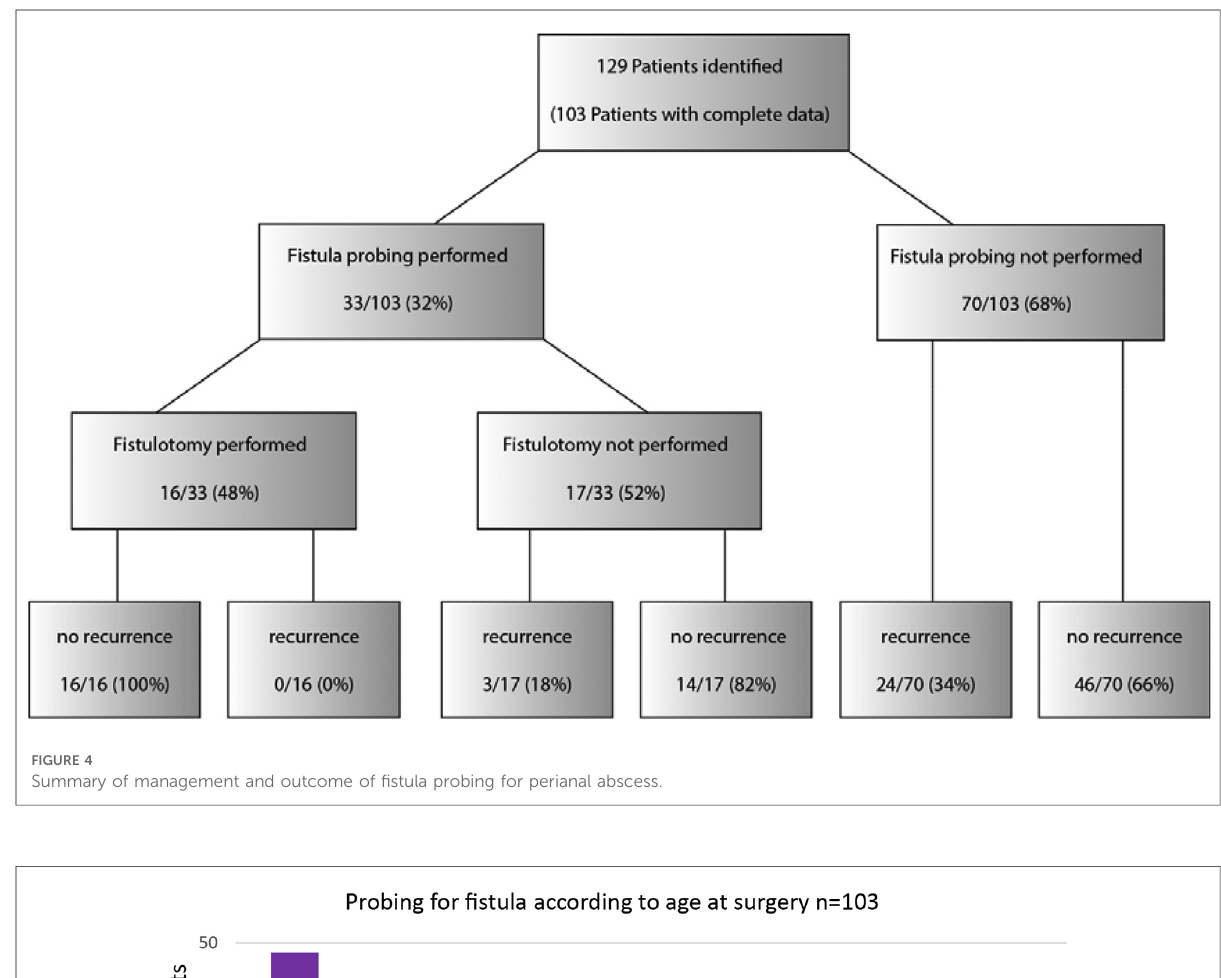
FIGURE 4 Summary of management and outcome of fi stula probing for perianal abscess.